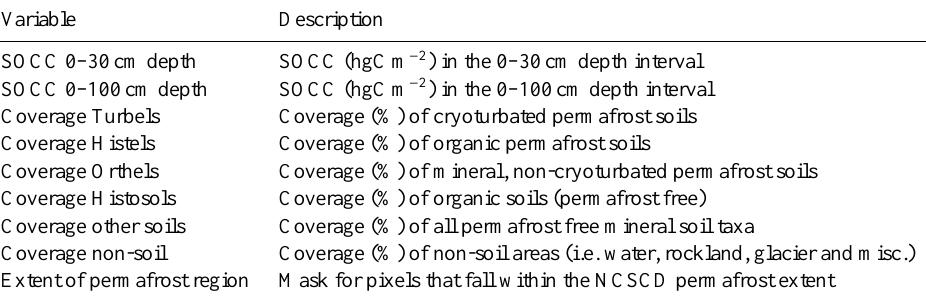
Table 3. Description of the NCSCD variables that have been converted to gridded file formats (TIFF-files and NetCDF-files). Each variable is stored in a separate gridded file; to describe the full soil / non-soil coverage in any pixel, all five grids describing coverage are